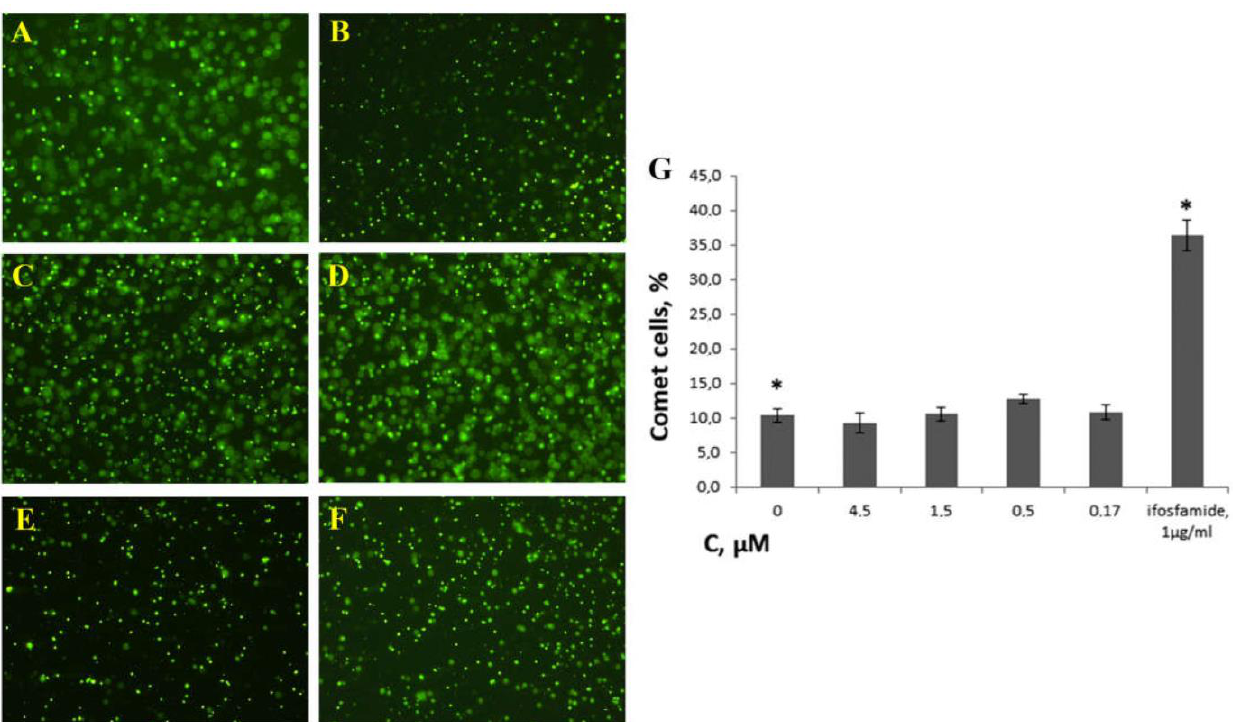
Figure 7. Effect of compound 14 on the number of ‘comet’ cells. NKE cells were incubated with the compound at final concentrations of 4.5 μM ( A ), 1.5 μM ( B ), 0.5 μM ( C ), and 0.17 μM ( D ) for 24 h. The negative control was physiological solution ( E ) and the positive control was ifosfamide 1 μg /mL ( F ). Histogram of the dependence of the comet cells proportion on the concentration of compound 14 ( G ). The proportion of ‘comet’ cells for the negative control population was 10.3 ± 1.03%; for conjugate 14 at concentration 4.5 μM, the proportion was 9.3 ± 1.39%; at concentration 1.5 μM, the proportion was 10.5 ± 0.89%; at concentration 0.5 µ M, the proportion was 12.7 ± 0.74%; at concentration 0.17 µ M, the proportion was 10.8 ± 1.03%. The proportion of ‘comet’ cells in the population treated with ifosfamide 1 µg/mL was 36.1 ± 2.14%, (* statistically significant difference with negative control, p > 0.01).